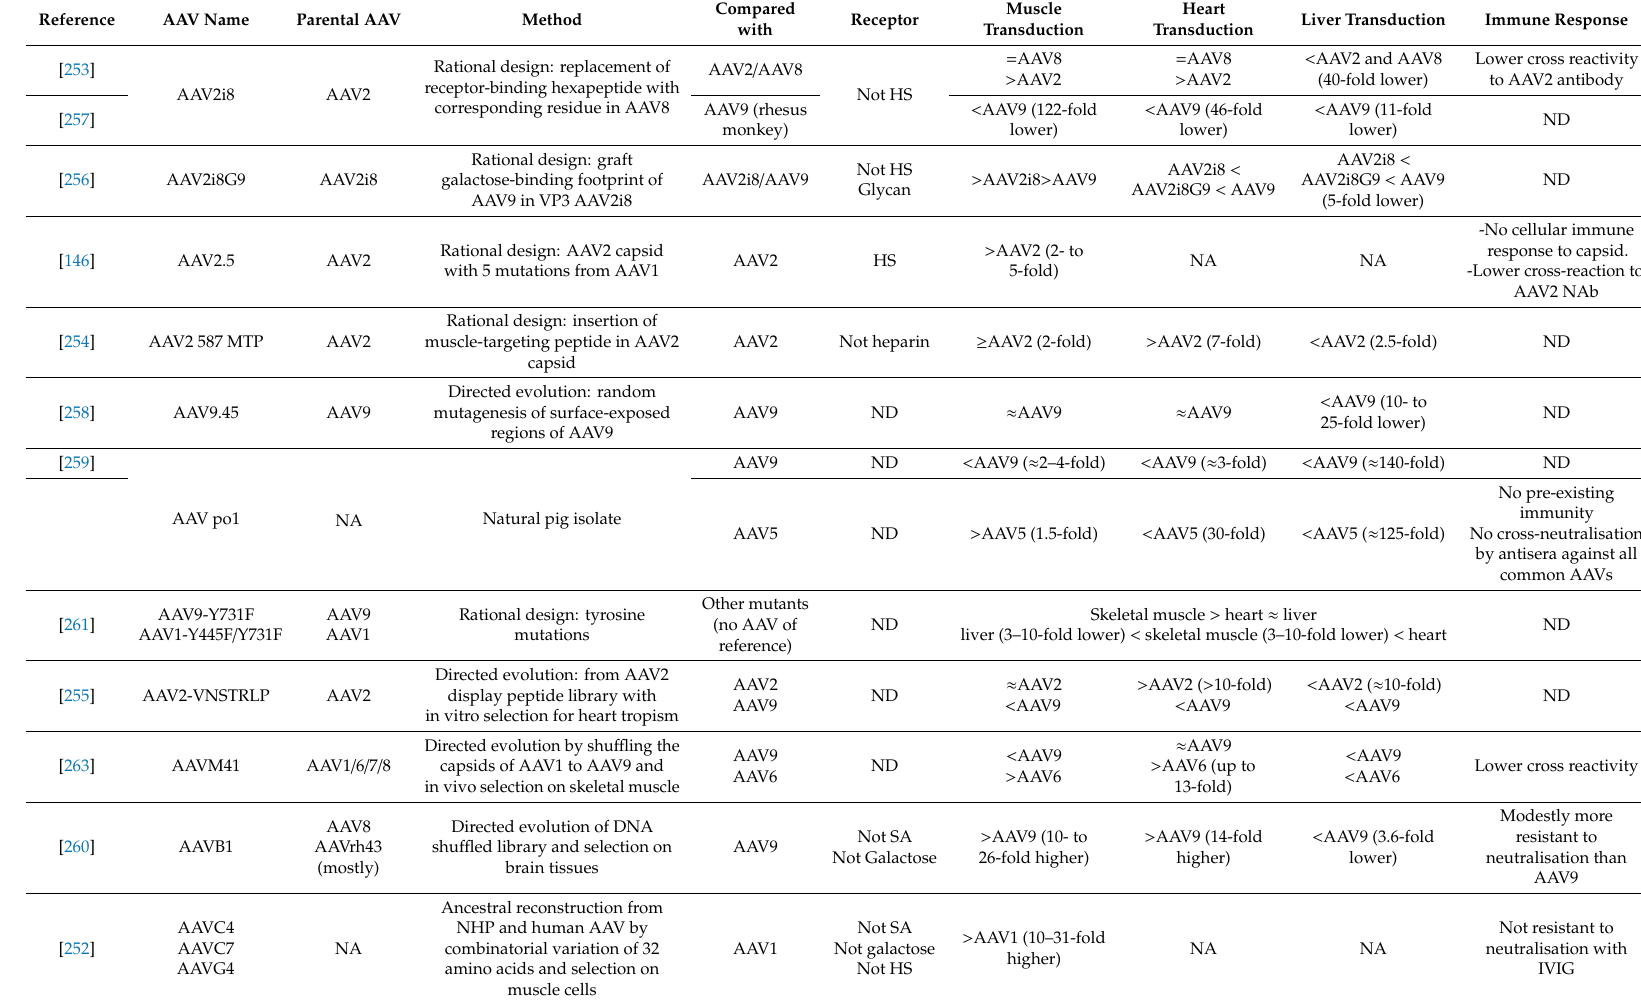
Table 4. Next-generation recombinant AAVs for improved muscle targeting, reduced liver targeting and / or a reduced immune